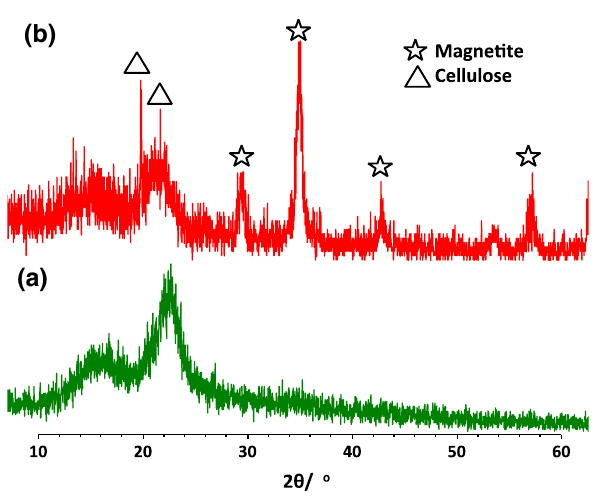
Fig. 2 X-ray diffraction patterns of a SWD and b SF-(2:1) nanomate- rials